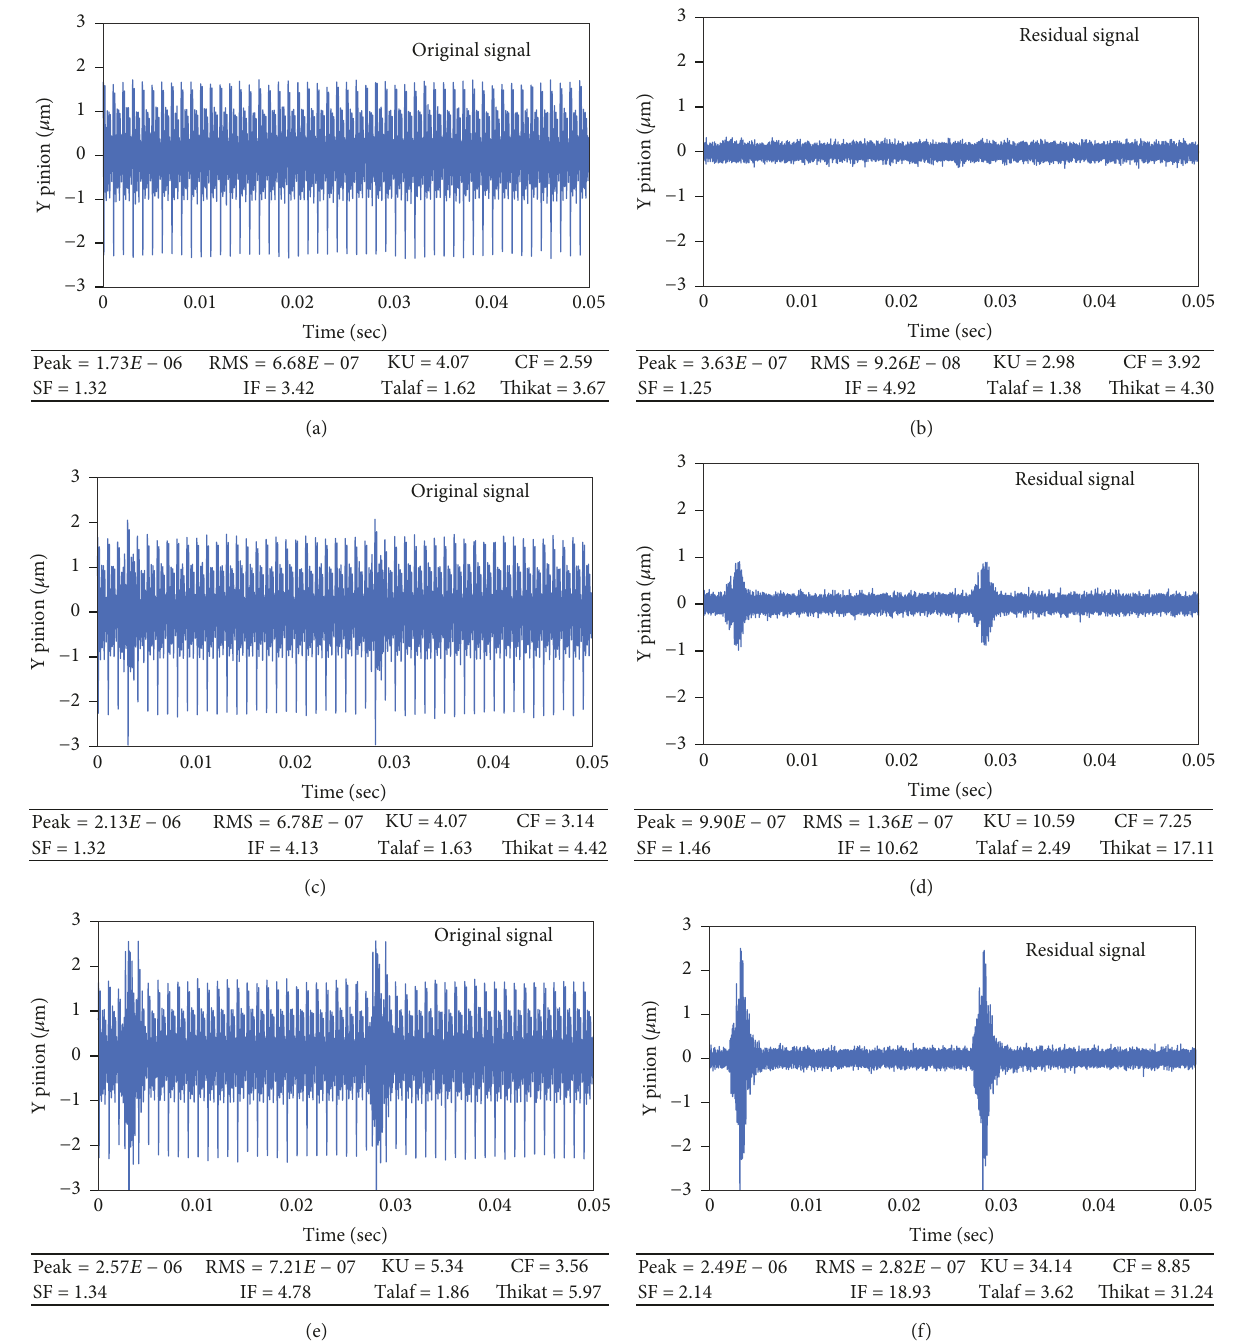
Figure 22: Time response simulation of gears with different CLP. (a & b) CLP = 0%; (c & d) CLP = 25%; (e & f) CLP =